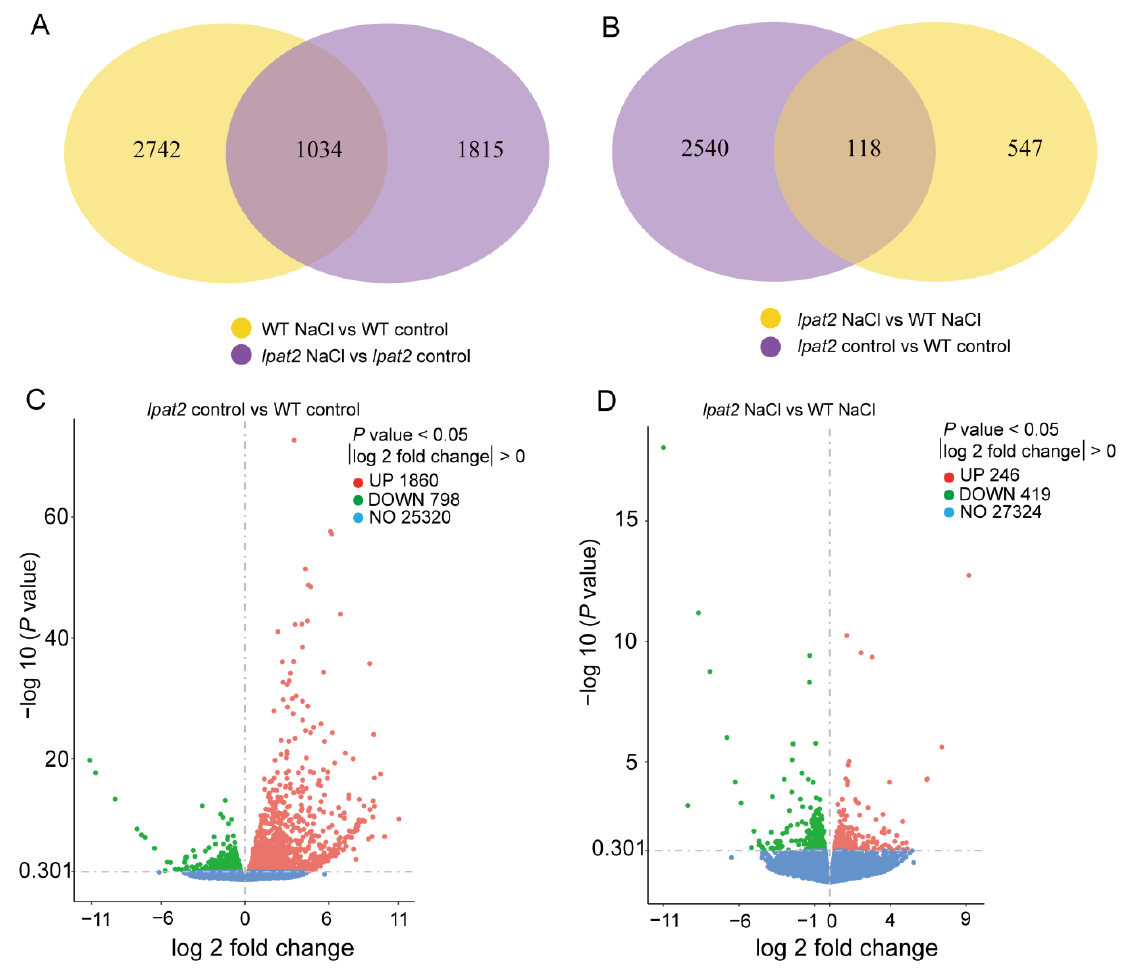
Figure 7. Suppressed LPAT2 led to a large number of differentially expressed genes (DEGs) under control and salt stress conditions. ( A ) The Venn diagram showing the differentially expressed genes (DEGs) of salt stress (100 mM NaCl) versus (vs.) control (without osmotic stress) in wild type (WT) and the lpat2 mutant. ( B ) The Venn diagram showing the DEGs of the lpat2 mutant vs. WT under control and salt (100 mM NaCl) stress conditions. ( C ) The numbers of upregulated and